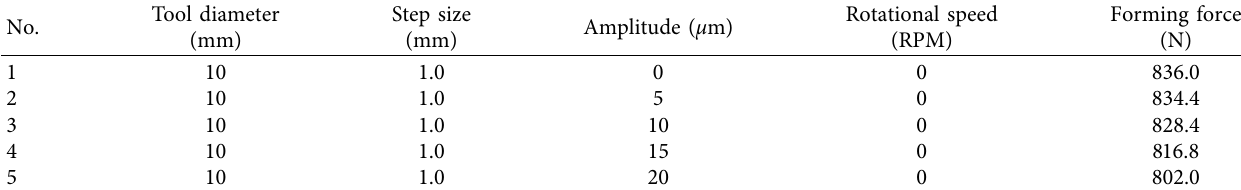
Table 6: Simulation setup and results with diferent